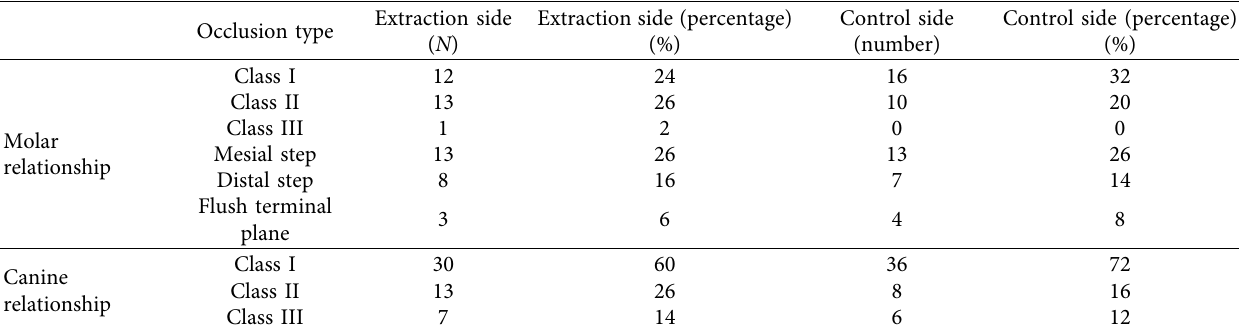
Figure 2: Measuring the distance between the distal surface of the primary canine and mesial surface of the permanent first molar on dental casts by using a caliper. Table 1: Extraction and nonextraction side with occlusion